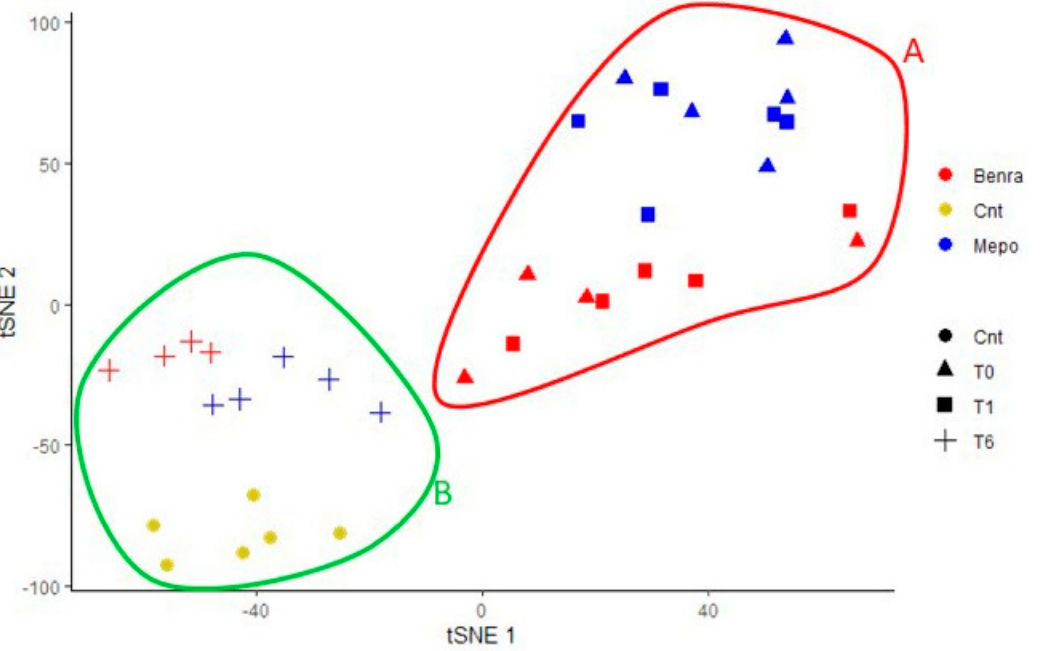
Figure 1. T-SNE plots of the six conditions were created using the %V data of all significant spots according to the variance in the overall cohort. Red circle includes T0, T1M, and T1B samples. Green circle includes T6M, T6B, and CTRL